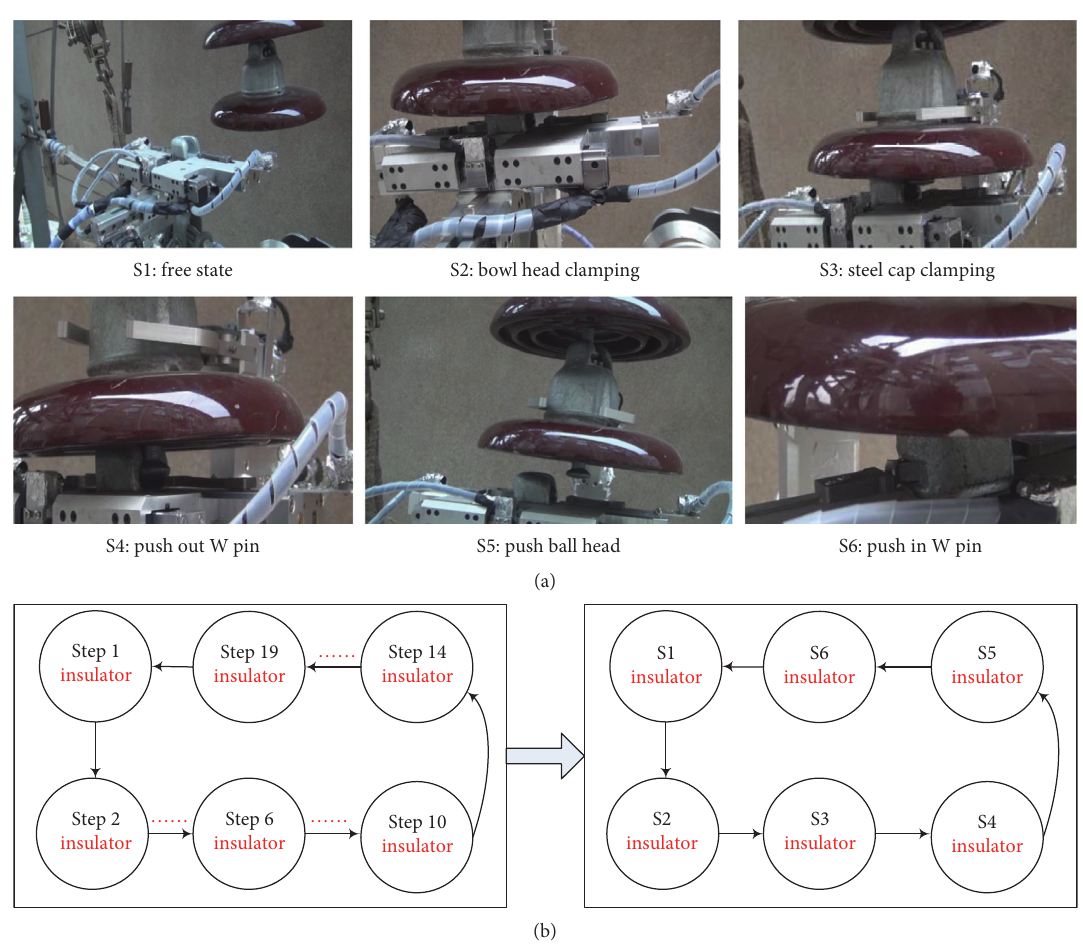
Figure 14: Field experiment of autonomous behavior control for insulator maintenance robot. (a) Insulator operation main process. (b) Insulator operation FSM